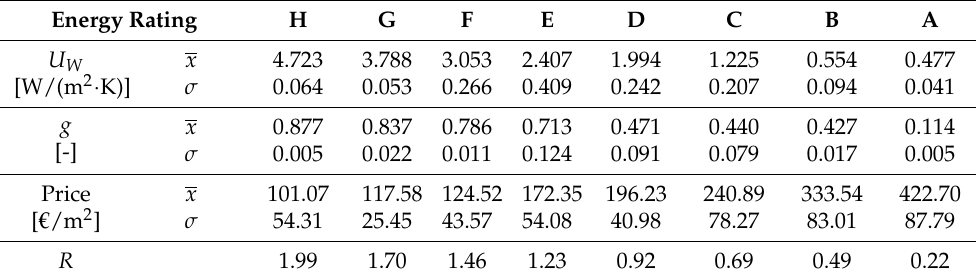
Table 8. Characterization of windows typically commercialized in the Portuguese market. Costs without VAT